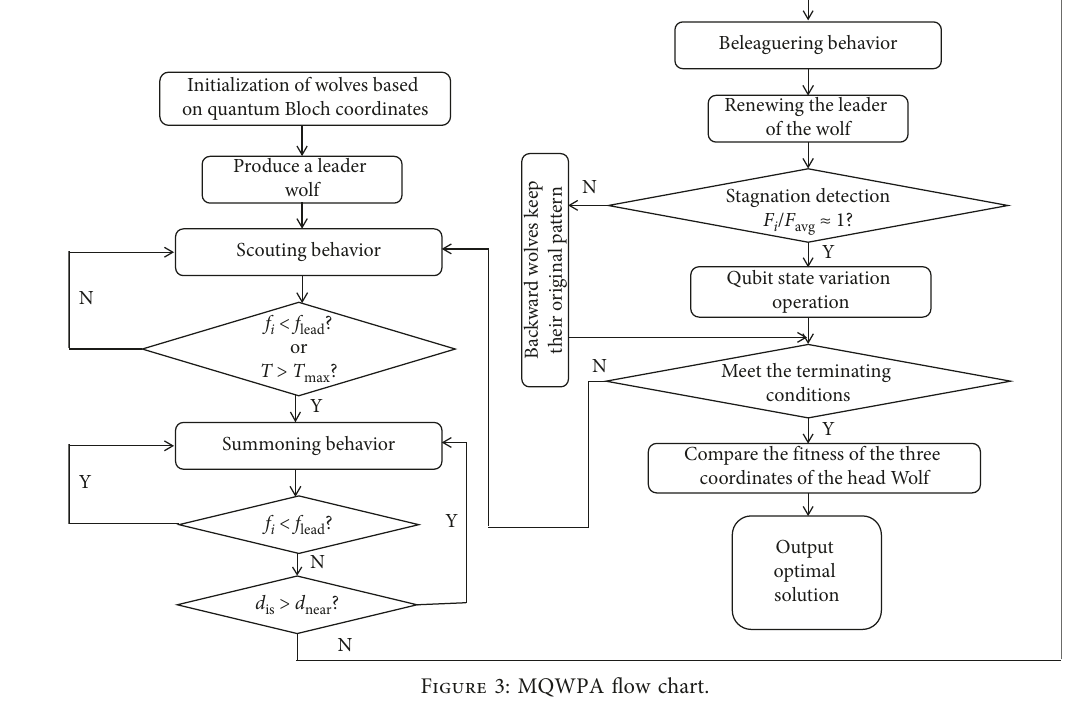
Figure 3: MQWPA flow